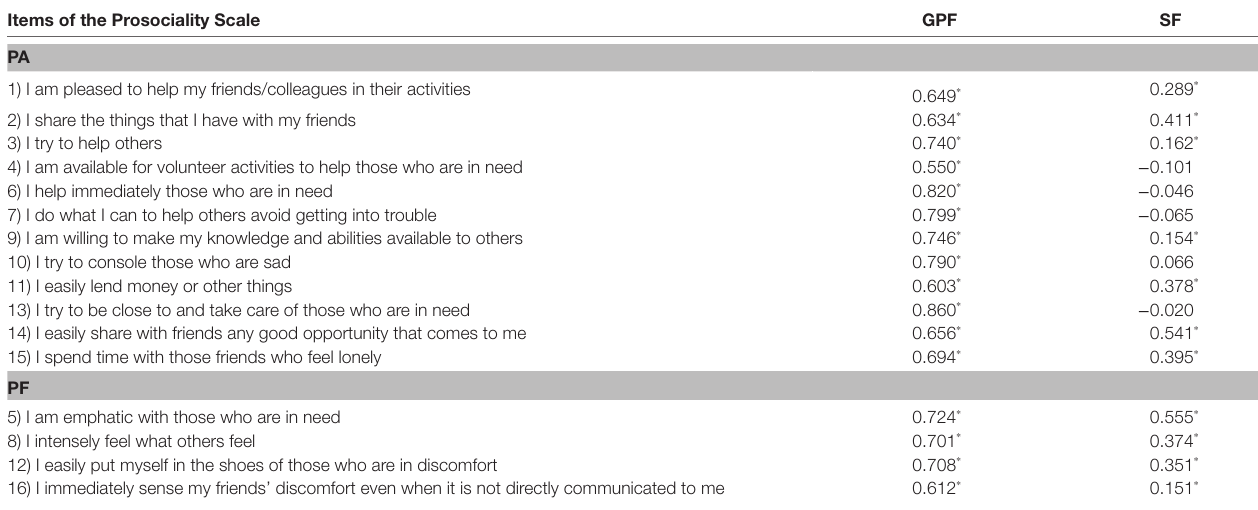
TABLE 1 | Standardized factor loadings in the bifactorial model from confirmatory factor analysis (CFA) of the Prosociality Scale in the Italian sample (Study 1). Items of the Prosociality Scale